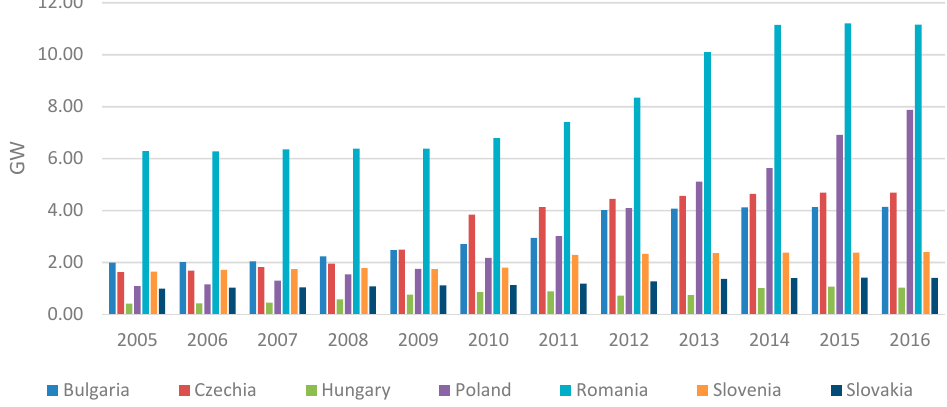
Figure 11. Renewable energy capacity evolution between 2005 and 2016 (GW), Source: Own representation based on IRENA data